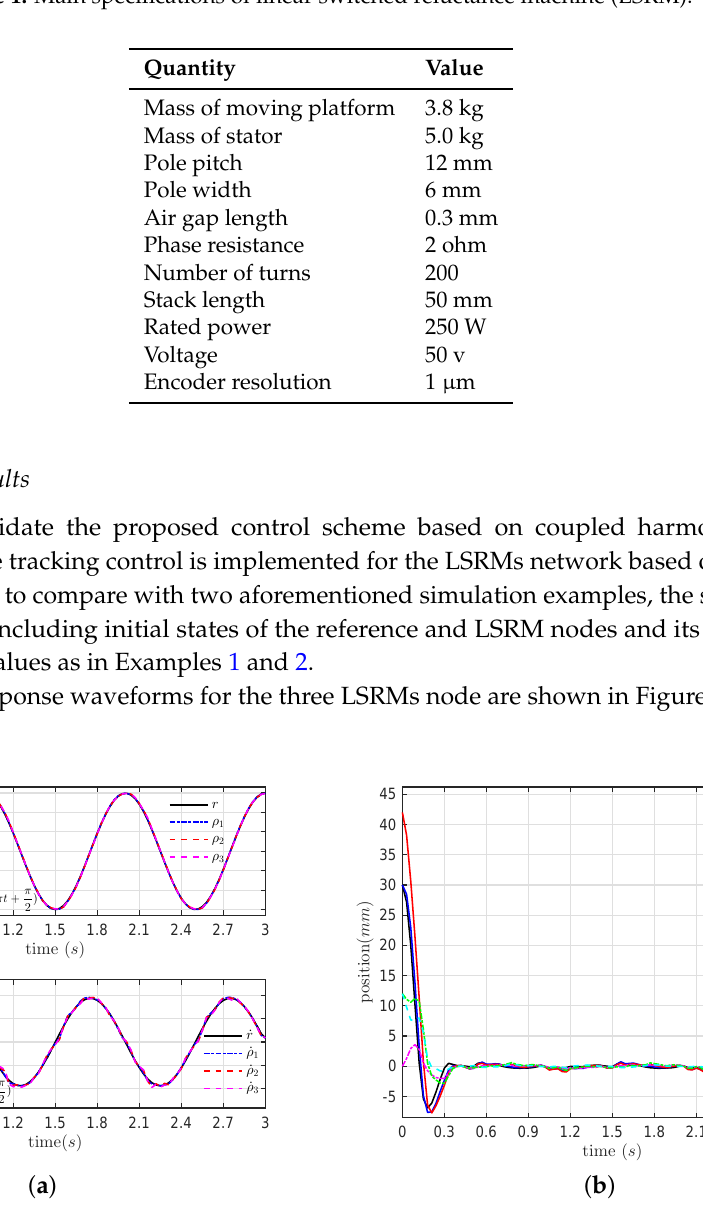
Table 1. Main specifications of linear switched reluctance machine (LSRM).